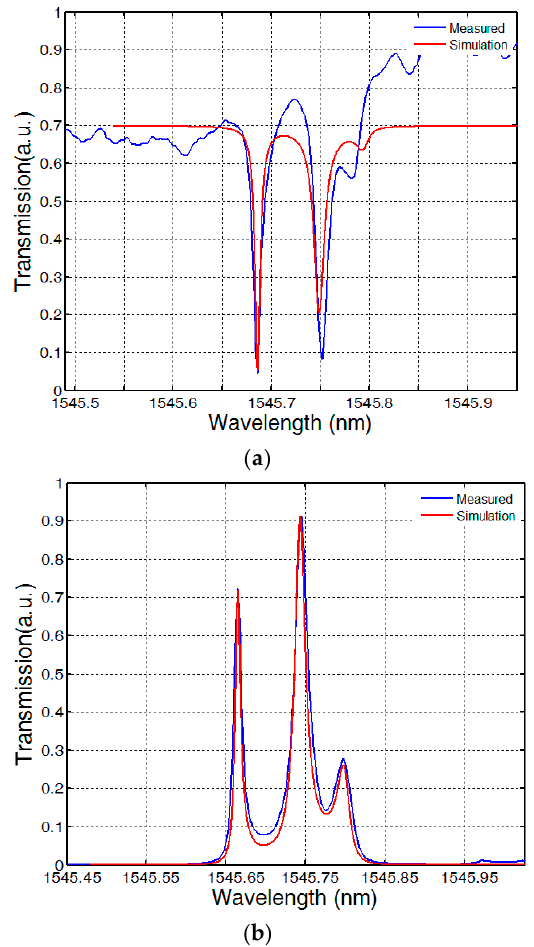
Figure 7. The measured transmission spectrum of ( a ) the through port and ( b ) the drop port. The blue line is the experimental result curve and red line is theoretical fitting curve.